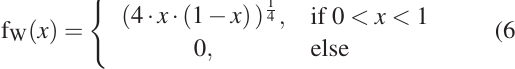
Fig. 1 : Dashed line: supplied sine current source, solid line: supplied sine voltage source, f = 30 Hz , (a) Maximal state change ∆ x max dependent on x 0 , ∆ t = T function of t for two different initial states and two source